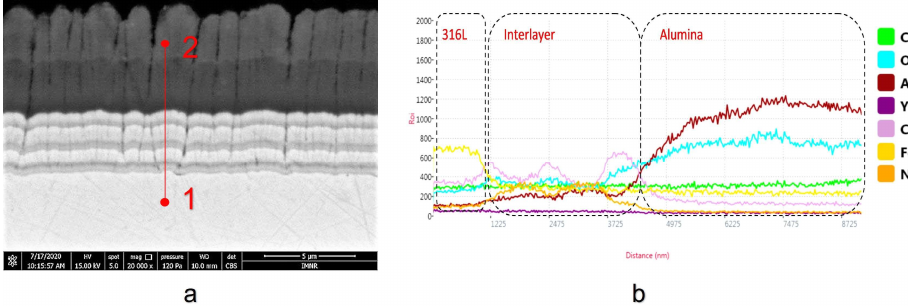
Figure 8. Cross-sectional analyses of the coated specimen: SEM ( a ) and EDS ( b ).